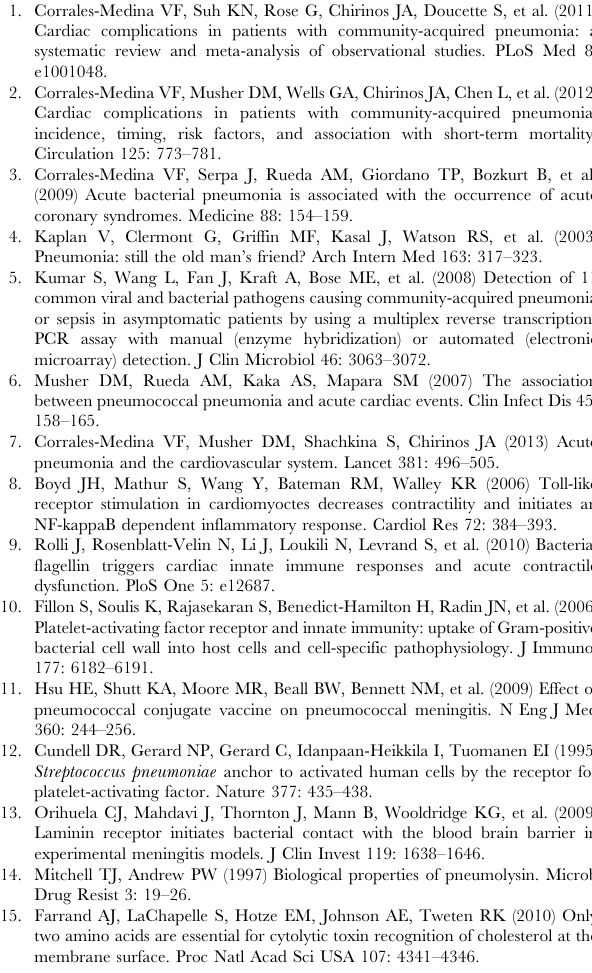
invasion. Lysis buffer served as the positive control for 100% cell toxicity while serum-free media was used as a negative control. Assay was performed using 4 wells per sample. Results shown are representative of duplicate experiments. Figure S4 A) Antibody response to pneumococcal protein constructions. Antibody titers to pneumolysin and CbpA in serum of mice as determined by ELISA following their immunization with the designated recombinant constructs. Circles represent values for individual mice. B) Levels of bacteremia following pneumococcal challenge. Bacterial titers in the blood of these same mice 24 h after high-dose intraperitoneal injection with 10 5 CFU TIGR4. Experimental cohort size: Alum =20; CbpA-R12=